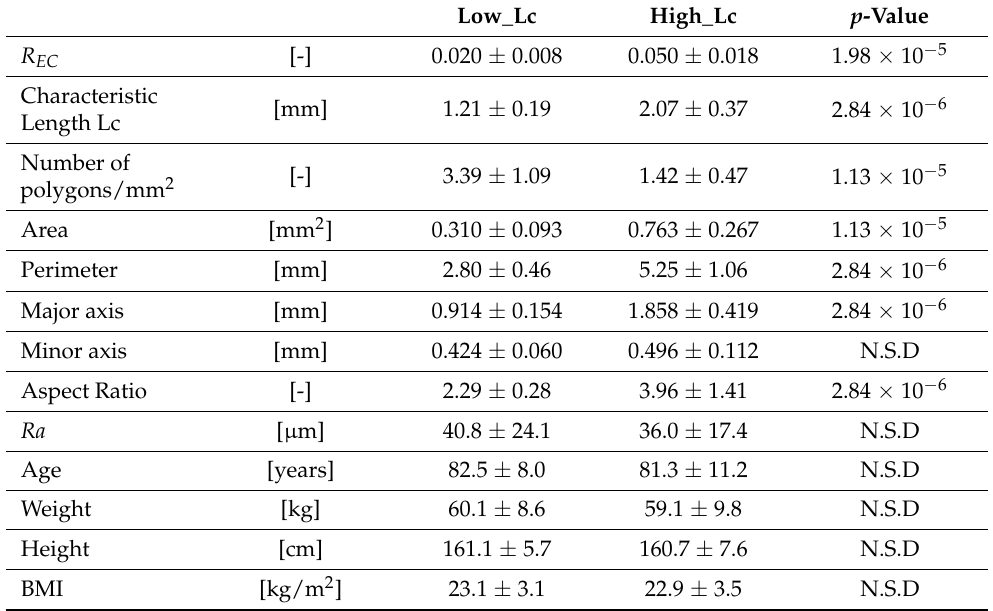
Table 2. Statistical results of experimental data (Elastin-to-Collagen ratio, watershed segmentation results and average roughness) and patient data (age, weight, height, BMI) for samples assigned to low or high characteristic length groups; N.S.D: no significative